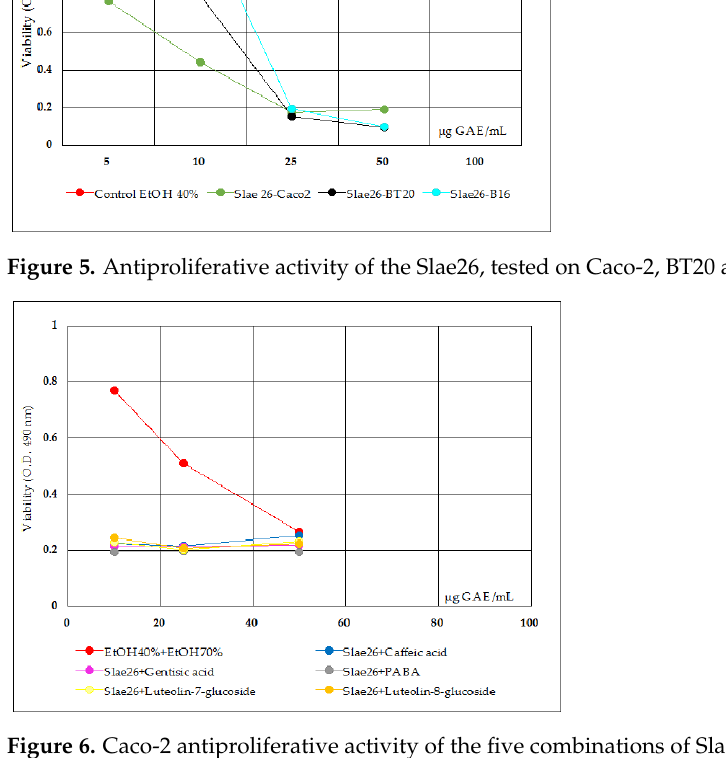
Figure 6. Caco-2 antiproliferative activity of the five combinations of Slae26 with the five reference compounds tested (phenolics, 1:1 w/w ratio of the active compounds in series), at 48 h